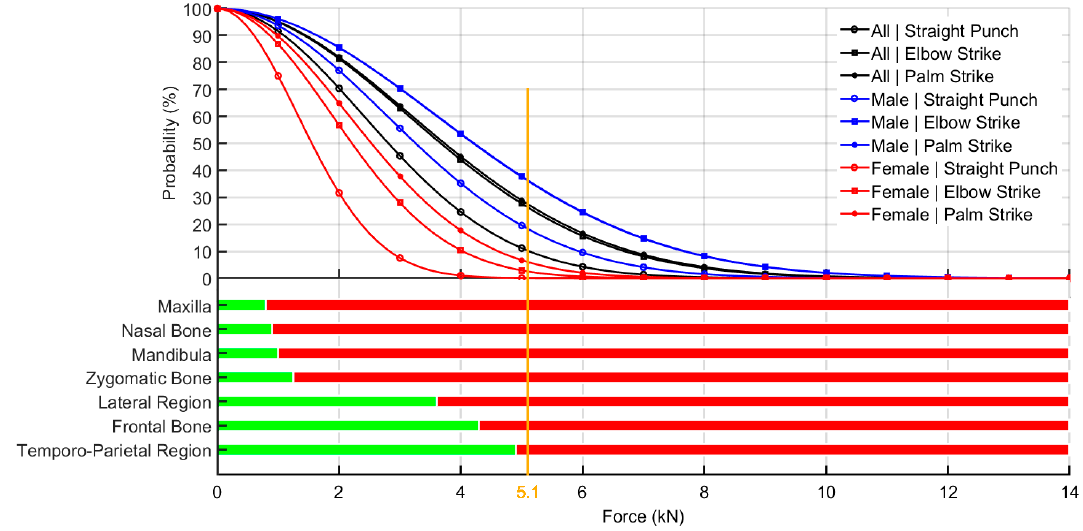
Figure 6. Probability of different strikes to exceed the 5.1 kN and bone tolerance. Green color – limits of allowed average load tolerance of bone fracture. Red color – over the limit of allowed average load tolerance of bone fracture.